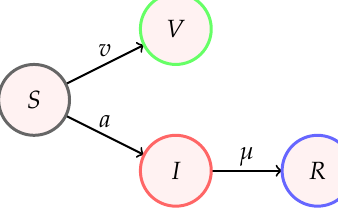
Figure 1. Three time-dependent rates a ( t ) , µ ( t ) , and v ( t ) entering the SIRV equations for the four compartments of susceptible, S , infectious, I , recovered, R , and vaccinated, V , population fractions. Upon introducing reduced time τ , the model is characterized by the assumed constant ratios k = µ ( t ) / a ( t ) and b = v ( t ) / a ( t )